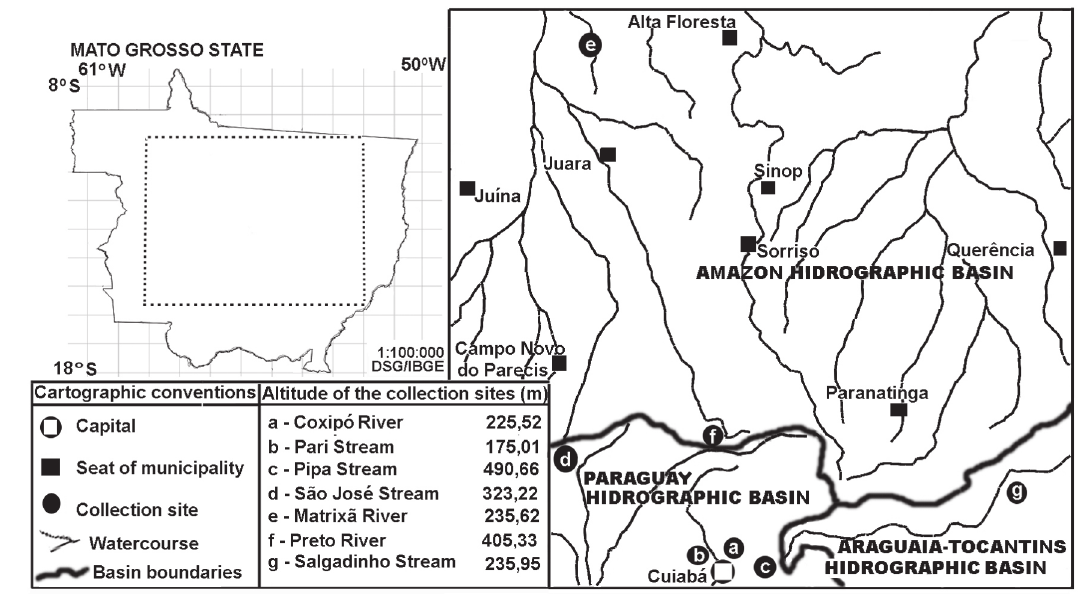
Fig. 1. Map of Mato Grosso State and sites crop (highlight-) showing Amazon, Araguaia-Tocantins and Paraguay hydrographic basins. Scale of original map